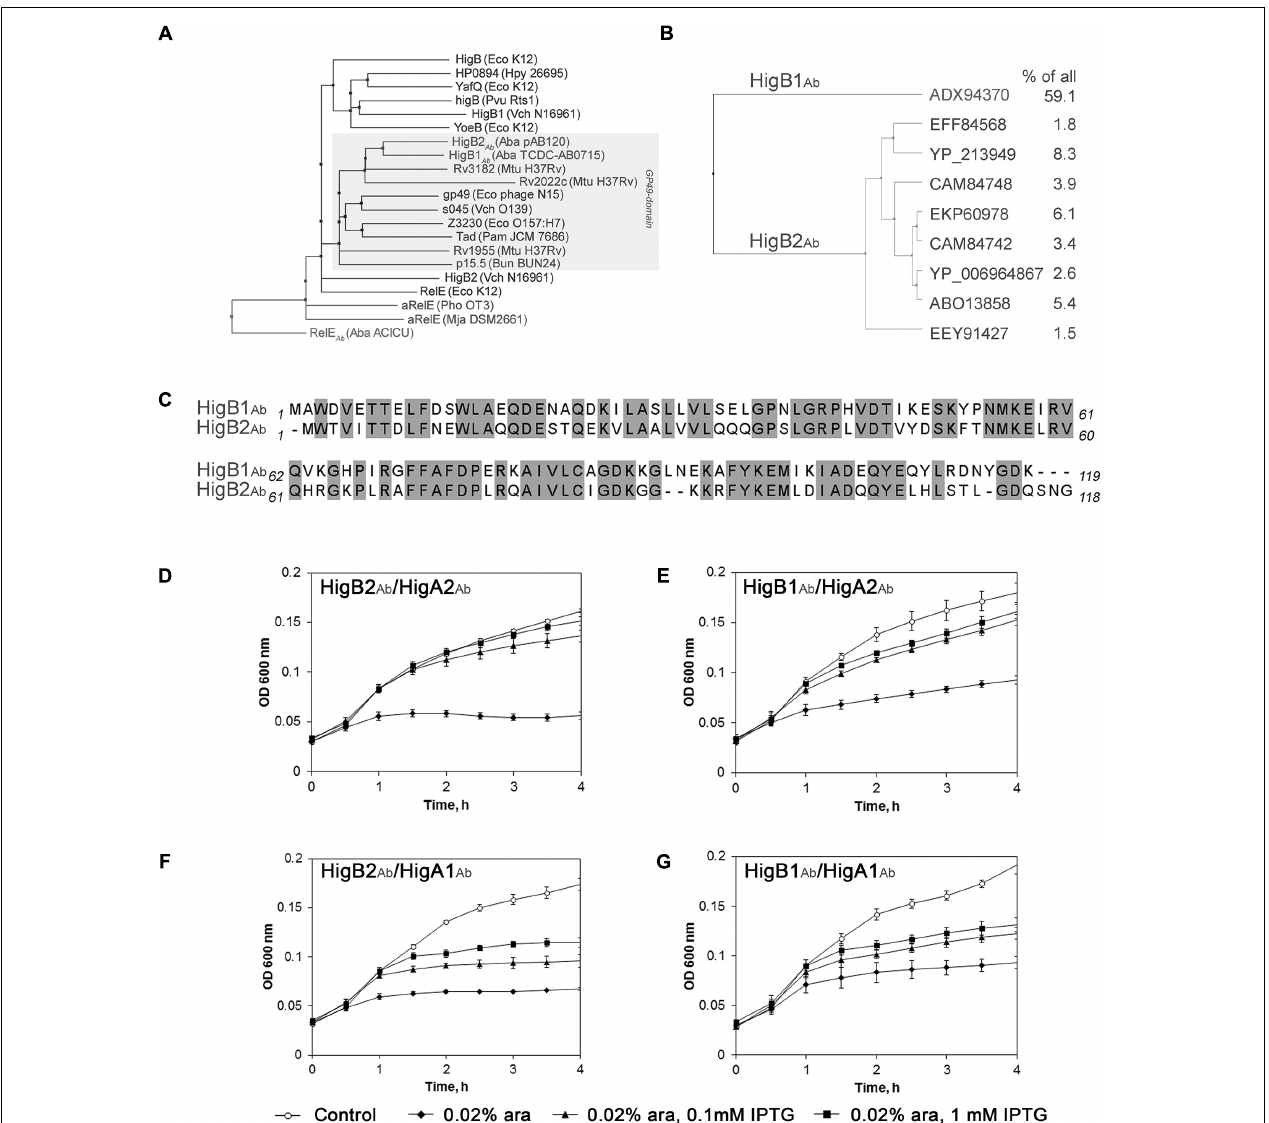
FIGURE 1 | Phylogenetic and homology analysis of Acinetobacter baumannii HigB Ab . (A) Cluster of GP49-domain toxin family within RelE superfamily, represented as neighbor joining tree. Gray box covers all GP49-domain proteins. The full organism names are provided in the Supplementary Material (Supplementary Table S3); (B) Two major lineages of HigB Ab toxins, represented as average distance tree. All proteins that have more than 1% identical hits in all deposited sequences are shown and their frequency in percentage is provided; (C) Alignment of pAB120-borne HigB2 Ab (Povilonis et al., 2013) and HigB1 Ab (Jurenaite et al., 2013) toxin sequences. Identical amino acid residues are outlined in gray boxes. All alignments were prepared as described in Section “Materials and Methods”; (D–G) Growth of Escherichia coli BW25113F (cid:48) harboring components of higBA Ab and their combinations. The E. coli strains with pUHE-“antitoxin” and pBAD30-“toxin” plasmids were grown until OD 600 = 0.1 and induced with 0.02% arabinose and/or with 0.1–1 mM IPTG as described in Section “Materials and Methods.” The data from three independent experiments are represented, the error bars indicate standard